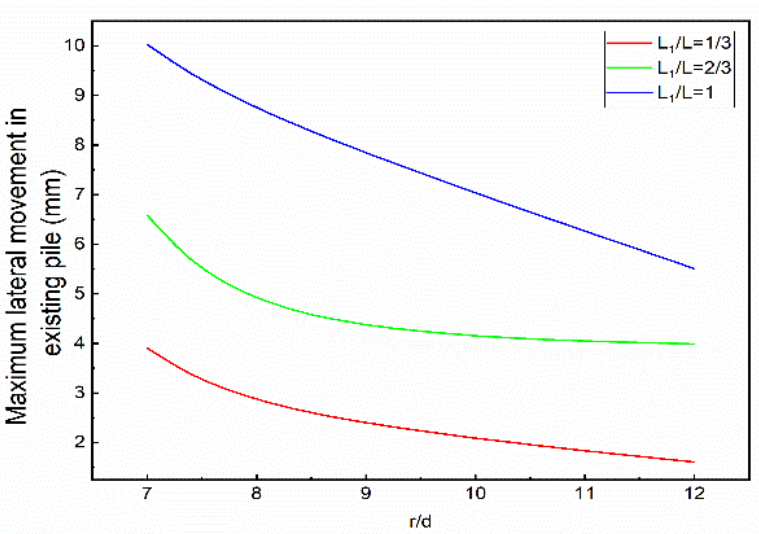
Figure 9. The impact of pile positioning on the maximum lateral displacement caused by a nearby driven pile.